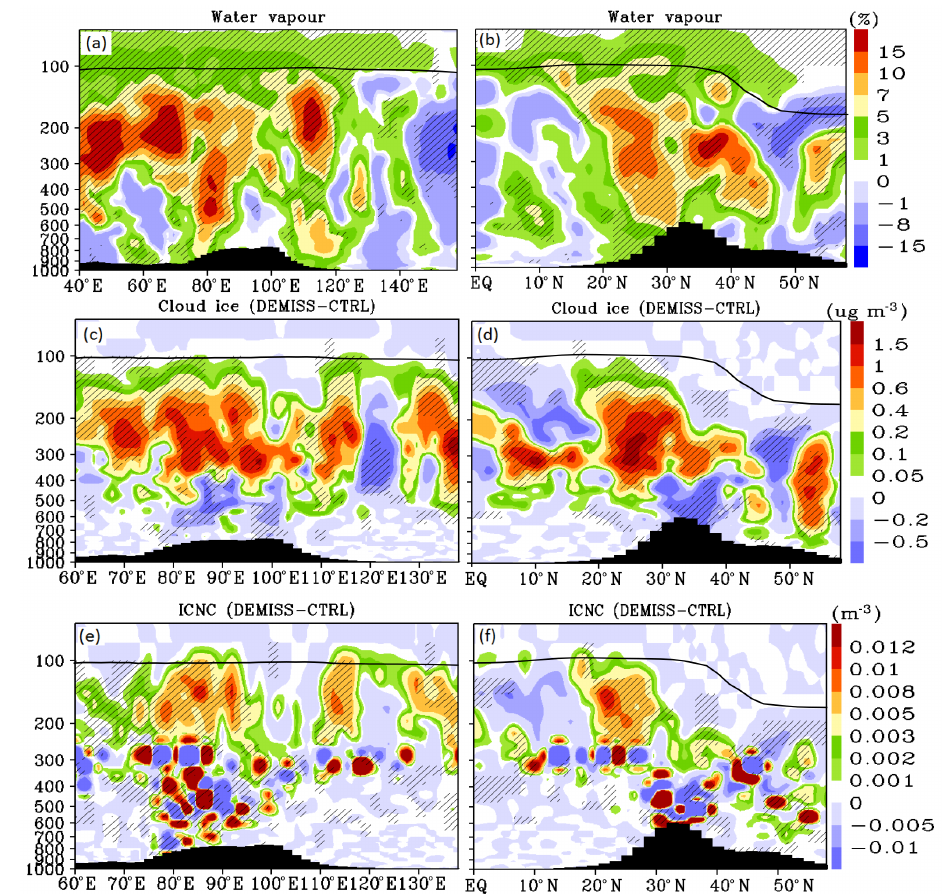
Figure 8. Distribution of anomalies (Demiss-CTRL) averaged for the monsoon season. (a) Water vapor (%) averaged over 15–35 ◦ N. (b) Same as (a) but averaged over 80–110 ◦ E. (c, d) Same as (a, b) but for cloud ice (µgm − 3 ) and (e, f) for ice crystal number concen- tration (ICNC) (m − 3 ) . A thick black line shows the tropopause while black hatched lines indicate the 99% confidence level. The tropopause is averaged for 15–35 ◦ N for panels (a, c, e) and 80–110 ◦ E for panels (b, d, f)